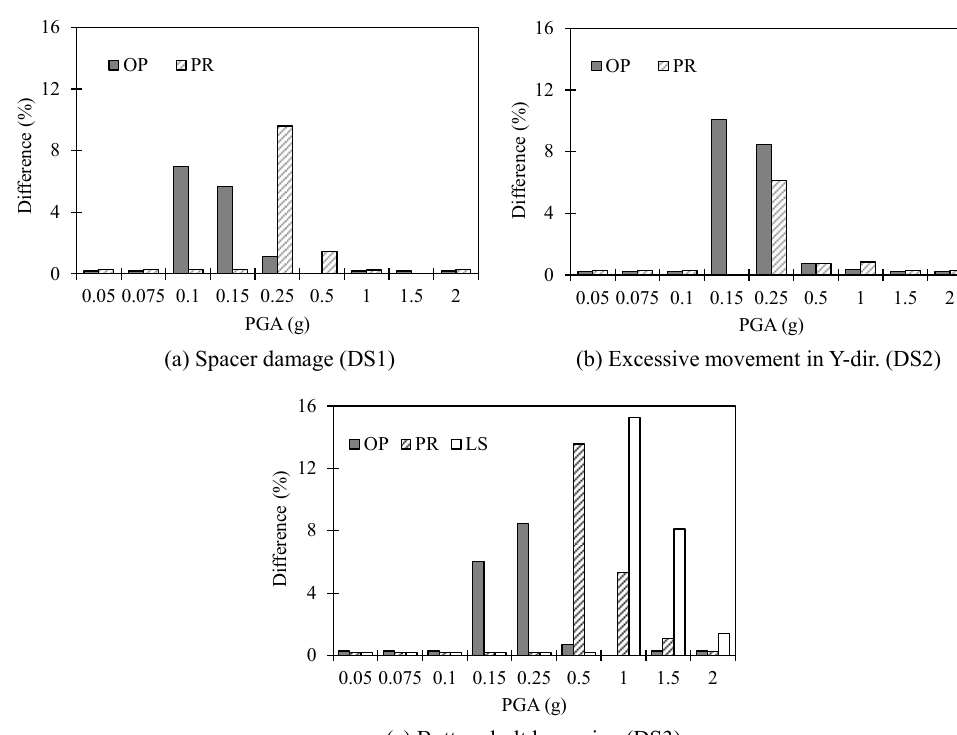
Figure 25. Differences in the probability of exceedance between analytical data and the fitted model of different damage states.